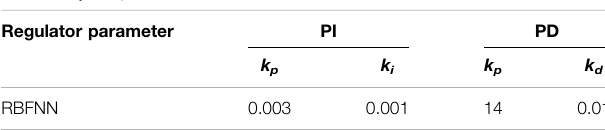
TABLE 7 | PID parameters of RBF NNIS.